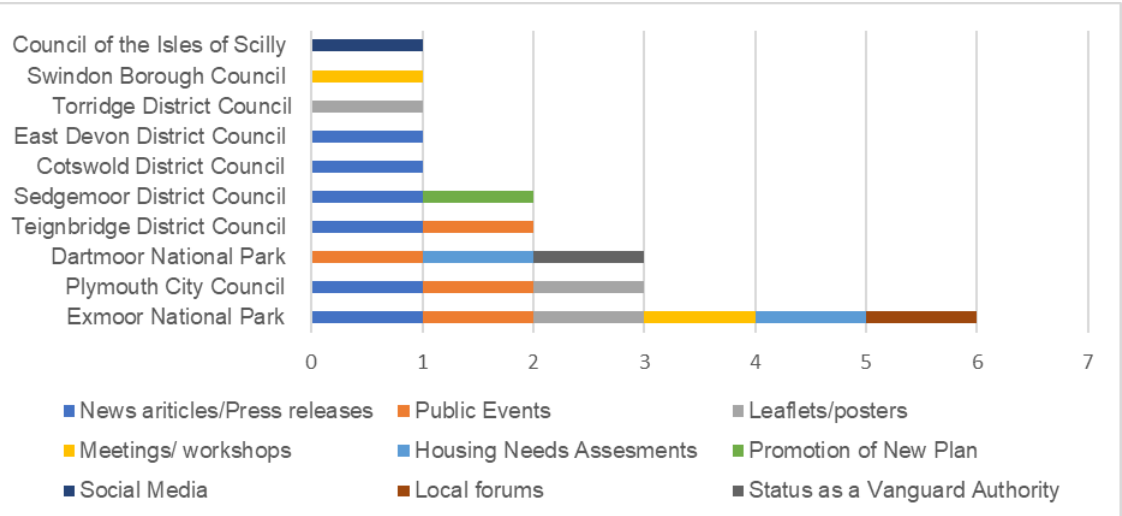
Figure 1. Methods used to publicise Registers (excluding webpages). Source: LPA Freedom of Information Responses.